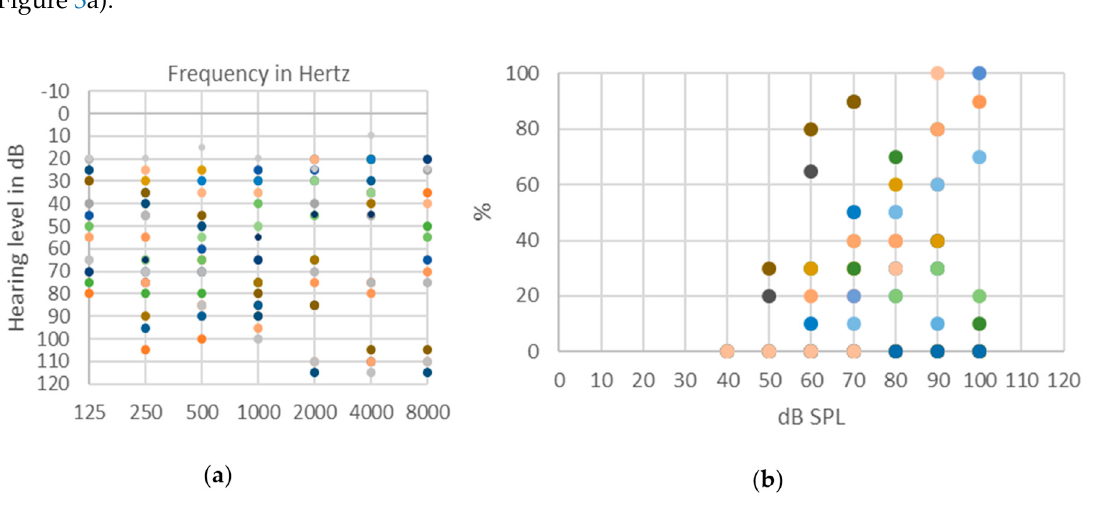
Figure 3. Distribution of pure-tone audiometry threshold ( a ) and (when possible) speech audiometry threshold for disyllabic words ( b ) in 14 patients aged between 5 and 48 years with auditory neuropathy spectrum disorder (ANSD). Etiologies of ANSD vary among patients. The figure is intended to show the large variability in hearing ability among patients with ANSD.